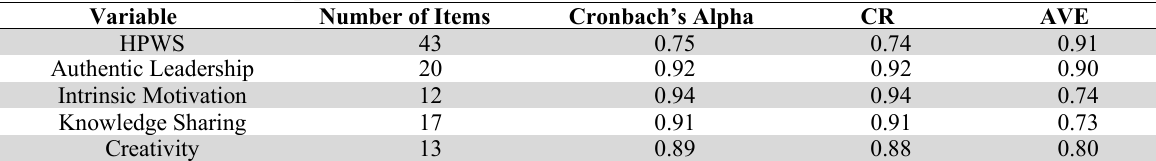
CR, AVE, & Cronbach Alpha Variable